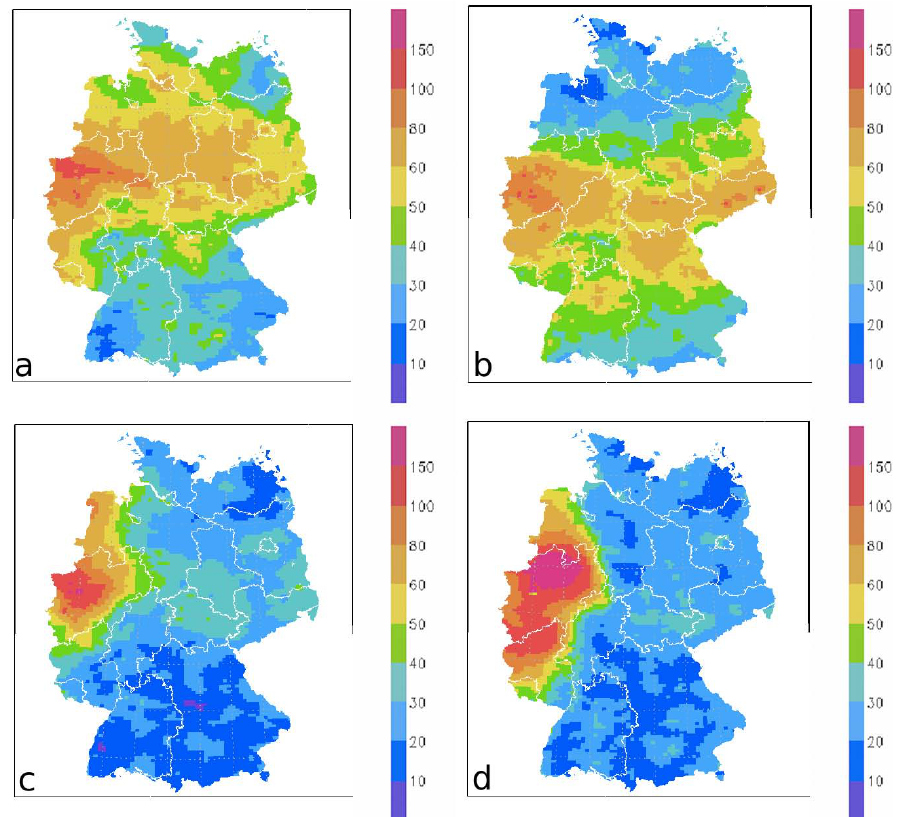
Fig. 4. Daily mean PM 10 concentrations in µgm − 3 on (a) 4 and (b) 5 April 2009 and (c) 12 and (d) 13 April 2009 derived by Optimal Interpolation of